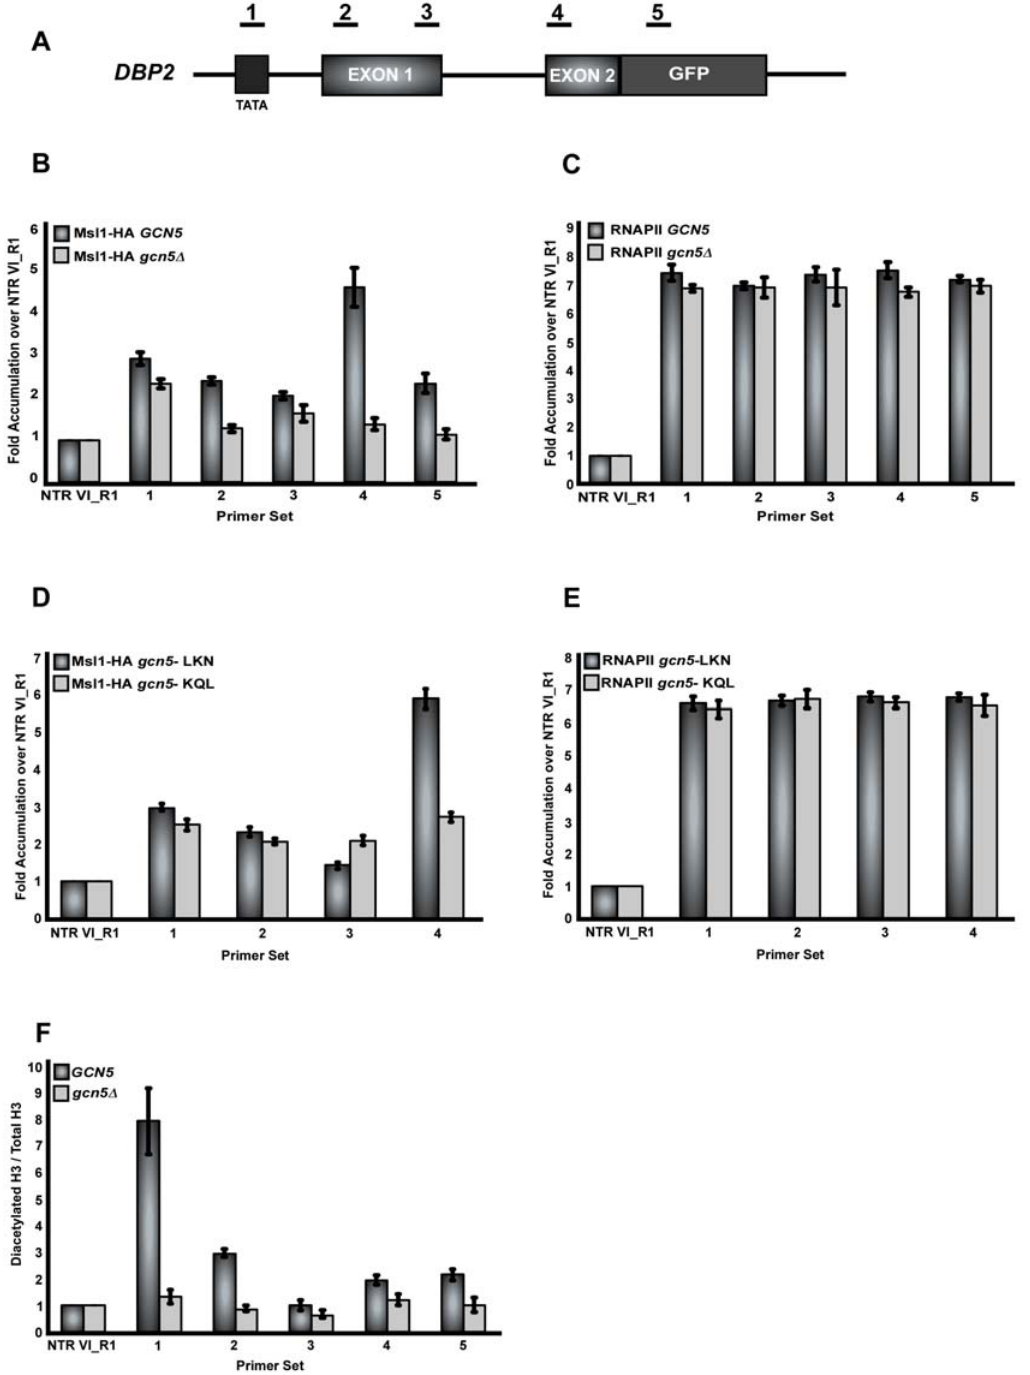
Figure 4. Deletion of GCN5 affects co-transcriptional recruitment of Msl1 to DBP2 . (A) Schematic of the intron-containing gene, DBP2 . Underlined numbers represent the amplicons generated from each primer set used in the study. (B) Graph depicting Msl1 occupancy within each region of DBP2 relative to the non-transcribed region, with wild-type or gcn5 D . Dark grey bars represent Msl1 occupancy in the presence of wild-type GCN5 and light grey bars represent Msl1 occupancy in the gcn5 D strain. (C) Bar graph depicting RNAP II occupancy within DBP2 . Dark grey bars represent RNA pol II occupancy in the MSL1-HA strain and light grey bars represent RNAP II occupancy in the MSL1-HA gcn5 D . (D) Graph depicting the Msl1 occupancy in the presence of the Gcn5 HAT mutants, LKN and KQL. Dark grey bars represent the levels of Msl1 with the Gcn5 LKN mutation, light grey bars represent Msl1 with the Gcn5 mutant KQL. (E) Bar graph depicting the occupancy of RNA pol II within DBP2 in the presence of the Gcn5 HAT mutants. Dark grey bars represent RNAP II with the Gcn5 LKN mutation and light grey bars represent RNAP II with the Gcn5 KQL mutant. (F) ChIP analysis of histone H3 K9/14 acetylation within DBP2 in wild-type and gcn5 D strains using an antibody directed against diacetylated histone H3 (Upstate). Dark grey bars represent wild-type and light grey bars represent histone acetylation in a gcn5 D strain. Data are represented as diacetylated histone H3 normalized to the total amount of histone H3 (Total H3). All graphs depict the average of at least three independent experiments, and error bars represent the standard deviation.